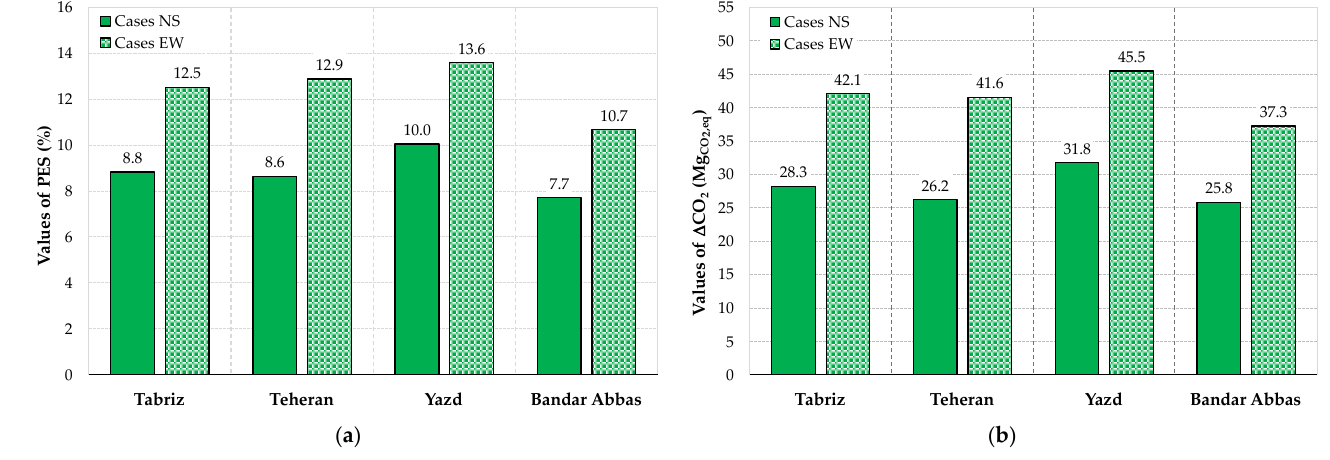
Figure 7. Values of ( a ) PES and ( b ) ∆ CO 2 according to location.